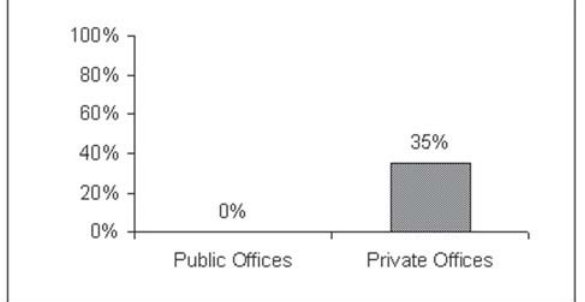
FIGURE 5- Distribution of dental professionals according to the supply of thyroid collar to patients during x-ray exposure. Araçatuba/SP,